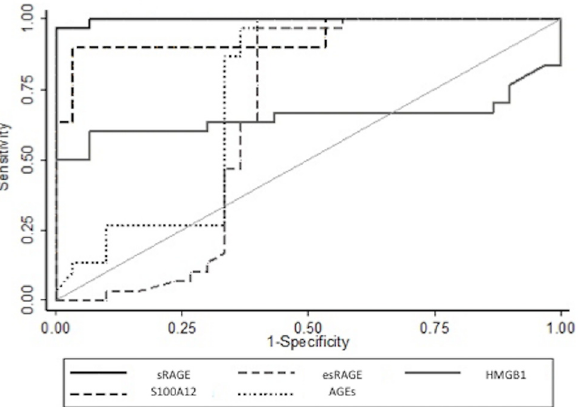
Fig 2. Receiver-operating characteristic curves of baseline arterial levels of sRAGE, esRAGE, HMGB1, S100A12 and esRAGE in differentiating between the presence and absence of ARDS on day